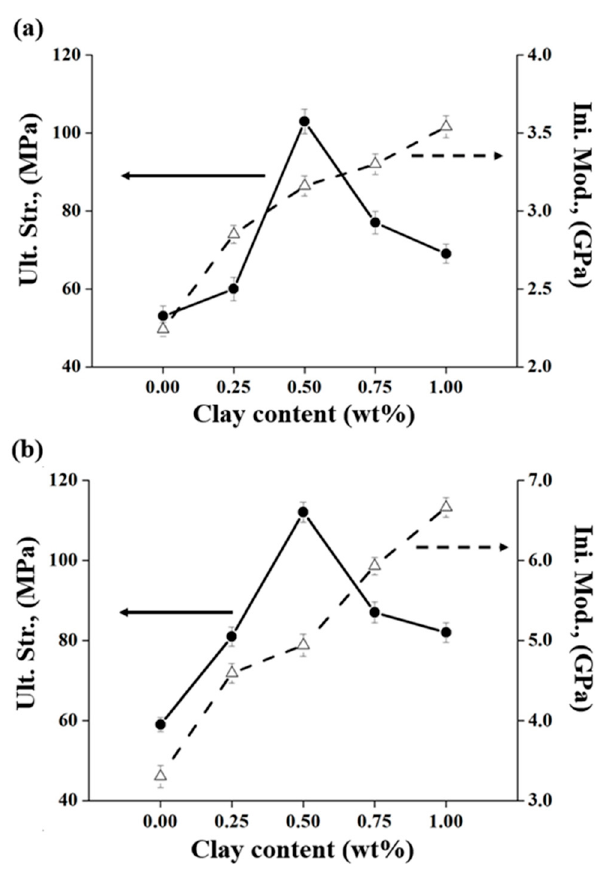
Figure 9. Tensile properties of PI hybrid films with various organoclay contents: ( a ) BAS and ( b ) BAS-OH.